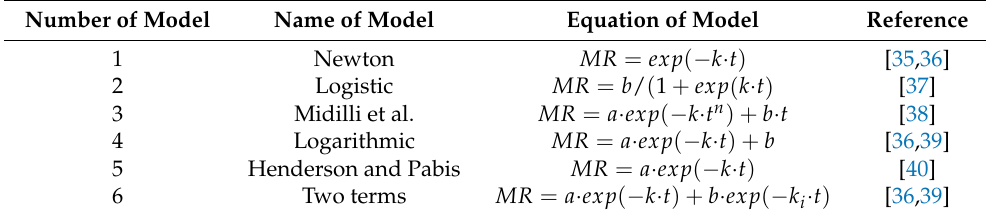
Table 2. Mathematical models applied to the drying process. Number of